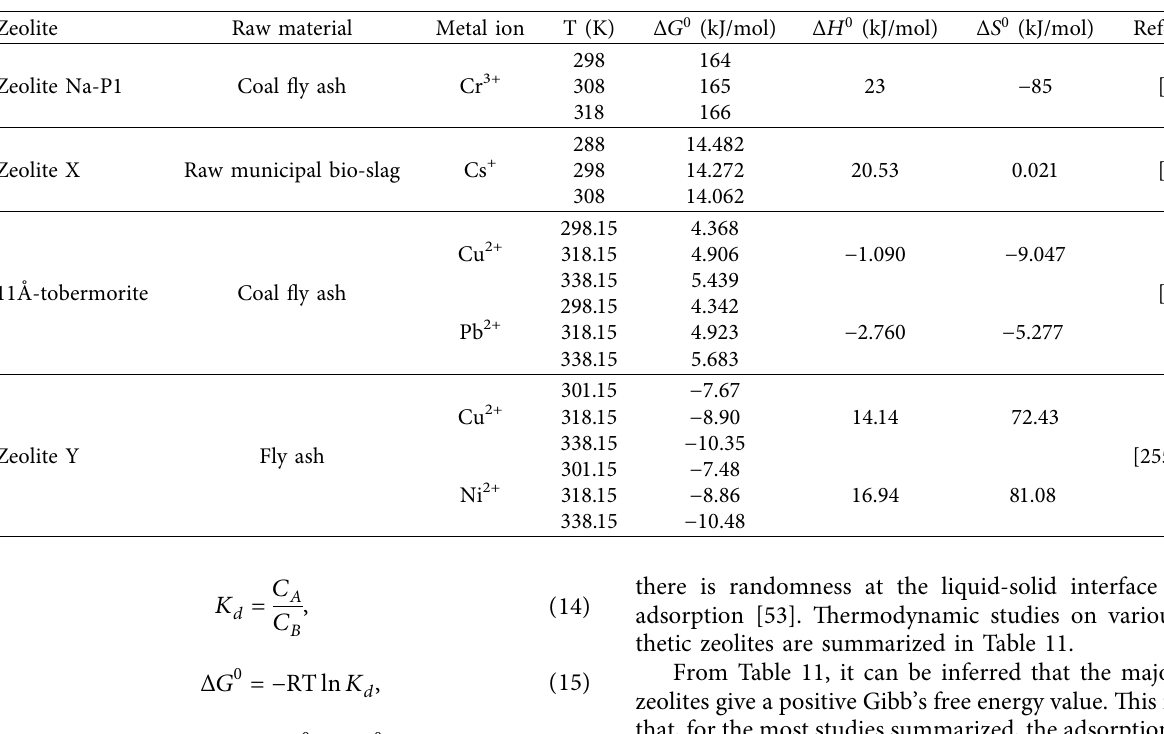
Table 11: Summary of adsorption thermodynamics on synthetic